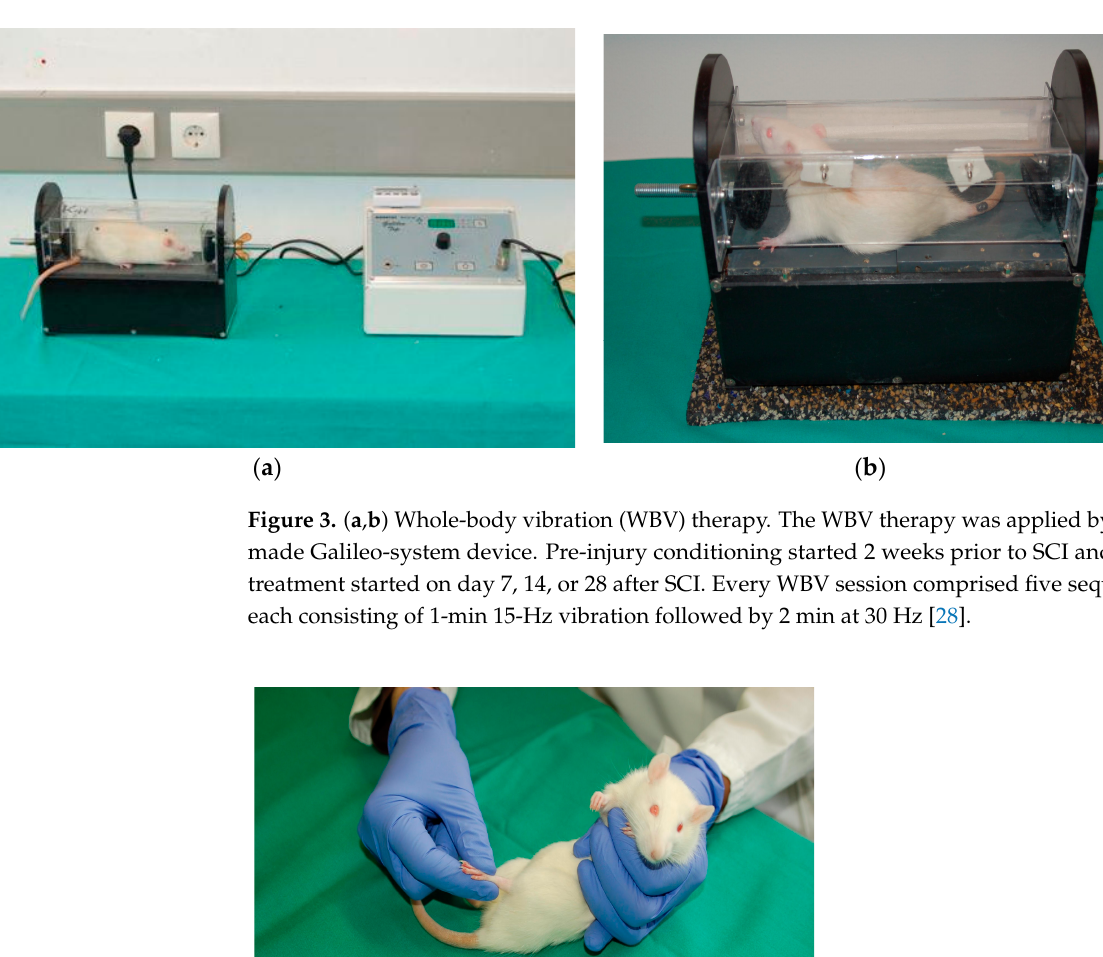
Figure 3. ( a , b ) Whole-body vibration (WBV) therapy. The WBV therapy was applied by the custom- made Galileo-system device. Pre-injury conditioning started 2 weeks prior to SCI and post-injury treatment started on day 7, 14, or 28 after SCI. Every WBV session comprised fi ve sequential trials, each consisting of 1-min 15-Hz vibration followed by 2 min at 30 Hz [28].